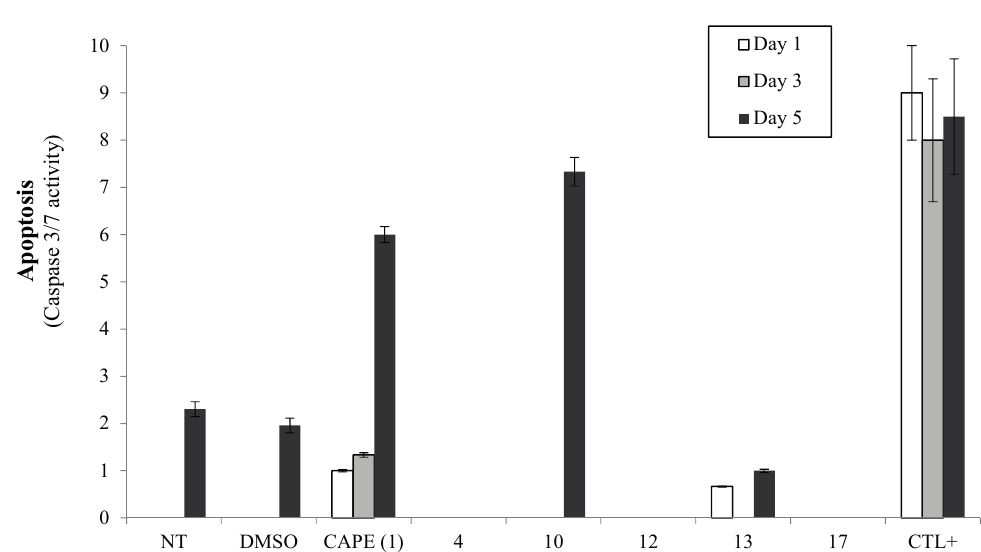
Figure 4. p53-Dependent apoptosis by CAPE derivatives in breast cancer cells. MB231 breast cancer cells were treated with 10 µM of selected compounds and incubated over time (24, 72 or 120 h) and evaluated for caspase-dependent apoptosis (Apo-ONE, Promega). Control samples include non-treated (NT) and solvent (DMSO) treated cells in addition to cells treated with apoptosis-inducing agent Melphalan (5 µM) as a positive control (CTL+). Results and standard deviations are representative of biological and experimental triplicates where the data is presented as the means ±